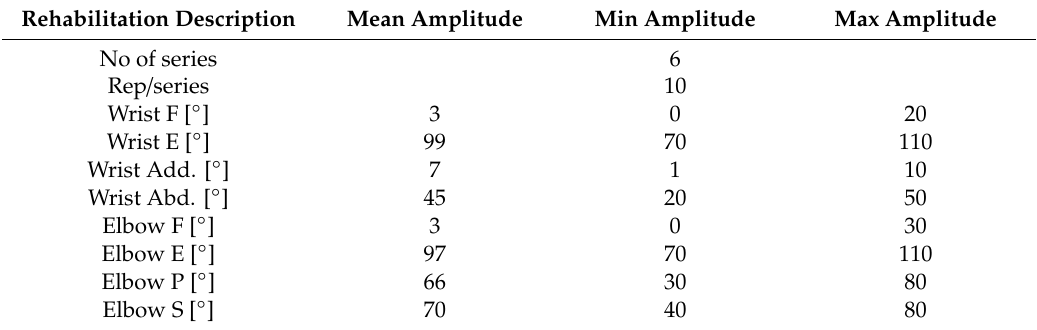
Table 8. Mean, minimum, and maximum angular amplitudes recorded during the clinical